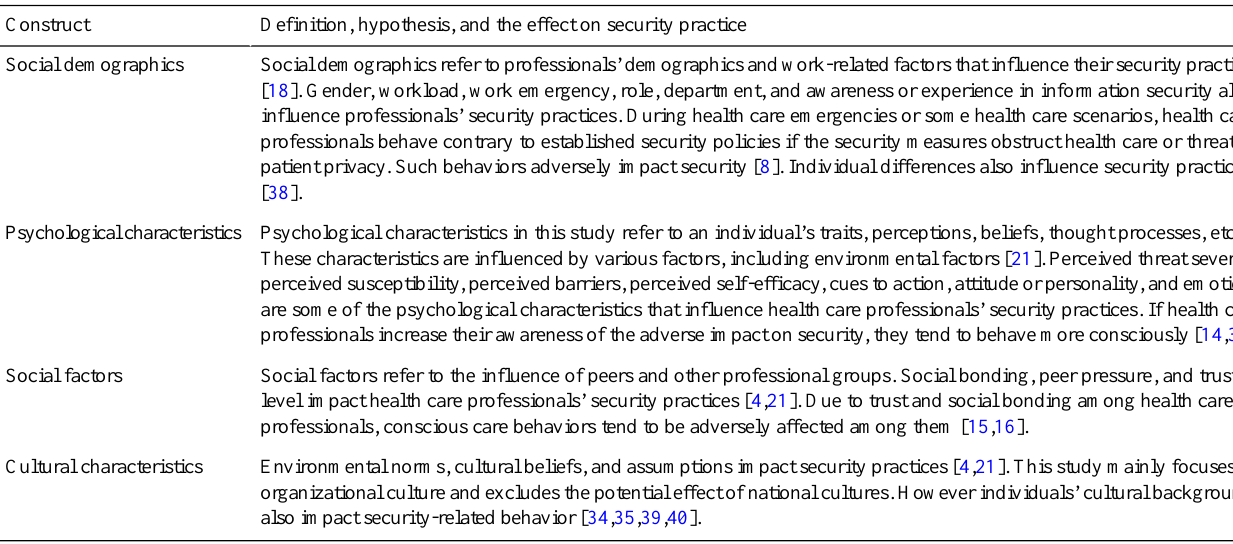
Table 1. Psychological, sociocultural, and demographic constructs.